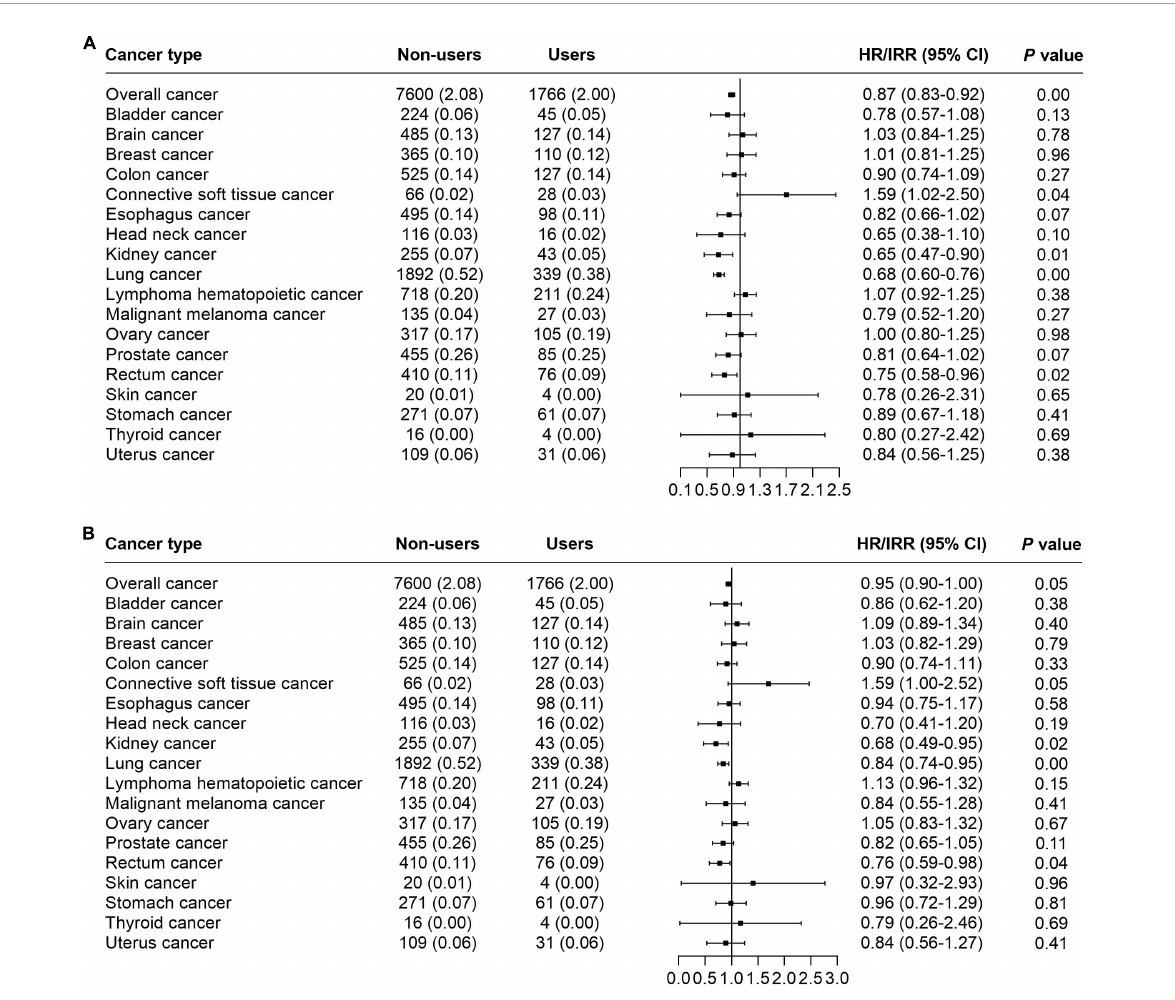
who were more than 60 years ( P for interaction =